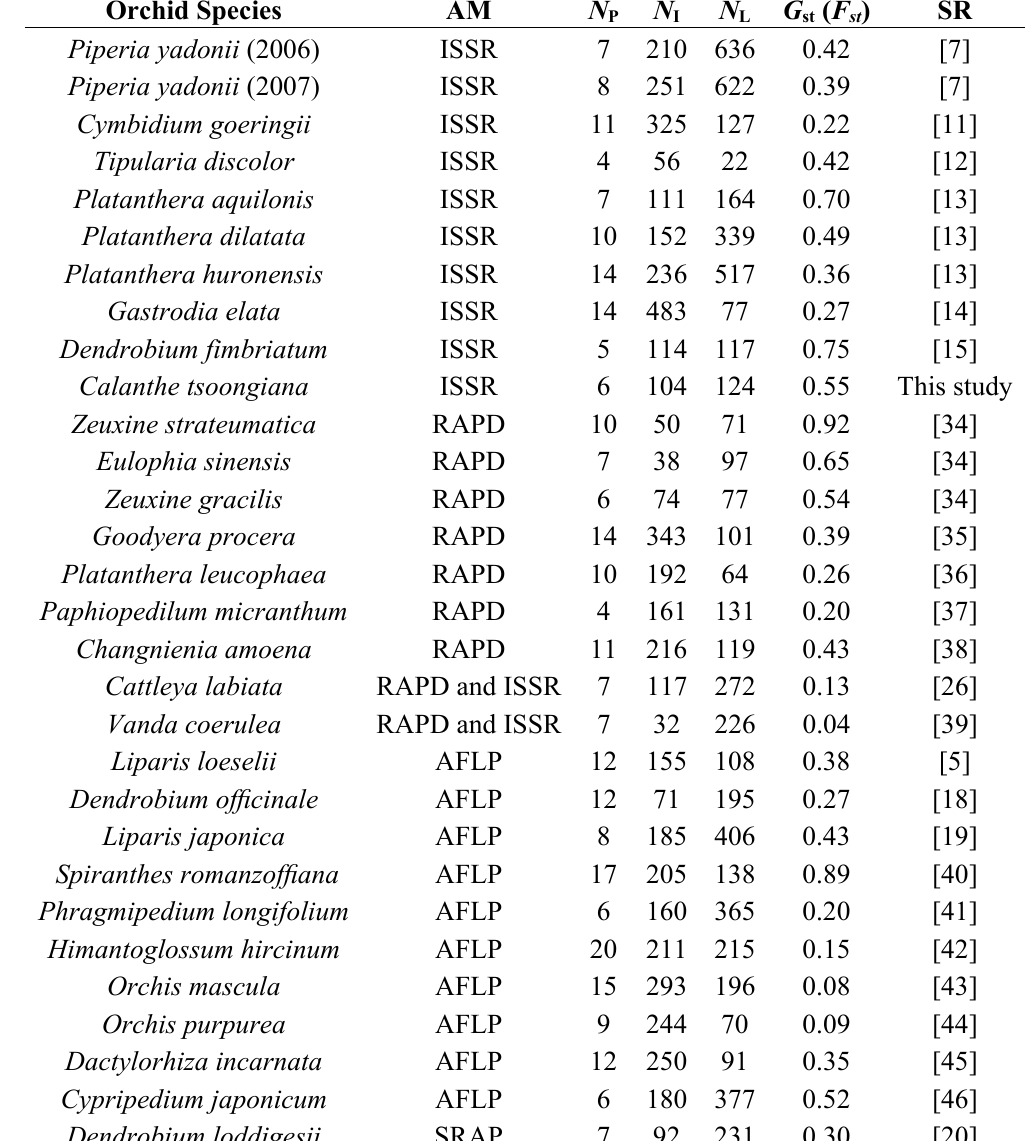
Table 4. Genetic differentiation among populations of orchid species based on dominant DNA